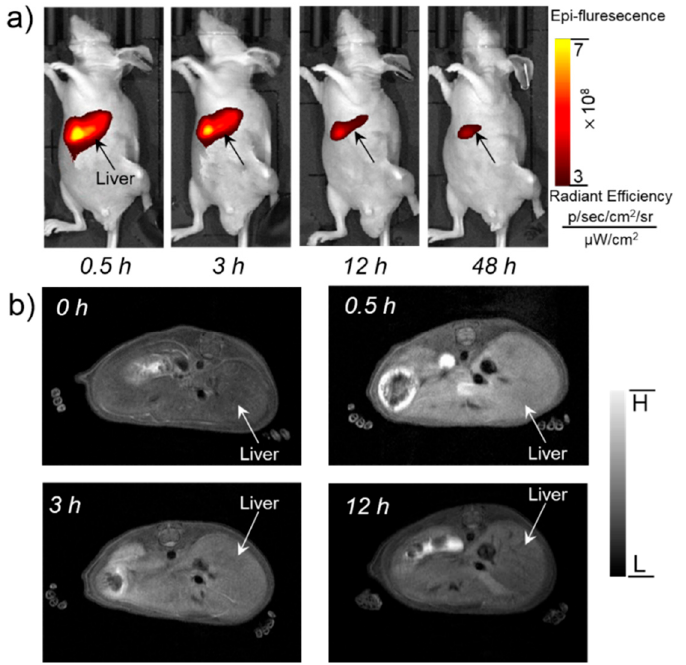
Figure 5. In vivo FI/MR imaging of Mn 3 O 4 @PEG-Cy 7.5 NPs. ( a ) Serial in vivo FI imaging of Mn 3 O 4 @PEG-Cy 7.5 NPs in BALB/c mice at different post-injection time points; ( b ) Serial in vivo MR imaging Mn 3 O 4 @PEG-Cy 7.5 NPs in BALB/c mice at different post-injection time points;